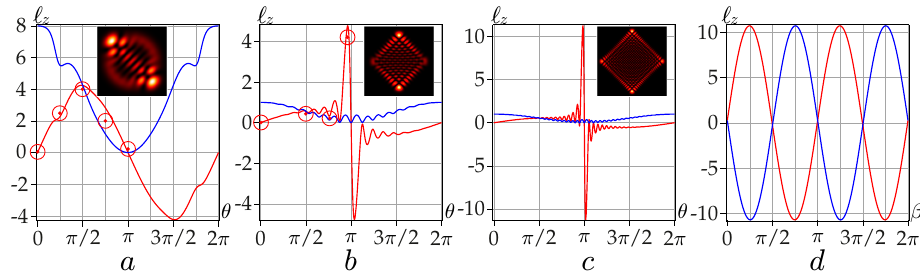
Figure 3. The OAM (cid:96) z of astigmatic-invariant sLG beams and its super bursts in the asLG beams as a function of the phase parameter θ ( a – c ) and the astigmatic parameter β ( d ). In the frame ( d ), (cid:96) z ( β ) for θ = π − 0.05 (red curve) and θ = π + 0.05 (blue curve) with ( n , (cid:96) ) = ( 20,1 ) . Other frames depict the curves (cid:96) z ( θ ) for β = 0 (blue curve) and β = π /4 (red curve) with ( n , (cid:96) ) = ( 0,8 ) ( a ), ( 8,1 ) ( b ), and ( 20,1 ) ( c ). The callouts demonstrate intensity patterns corresponding to the main maxima of the OAM. Experimental points are indicated by